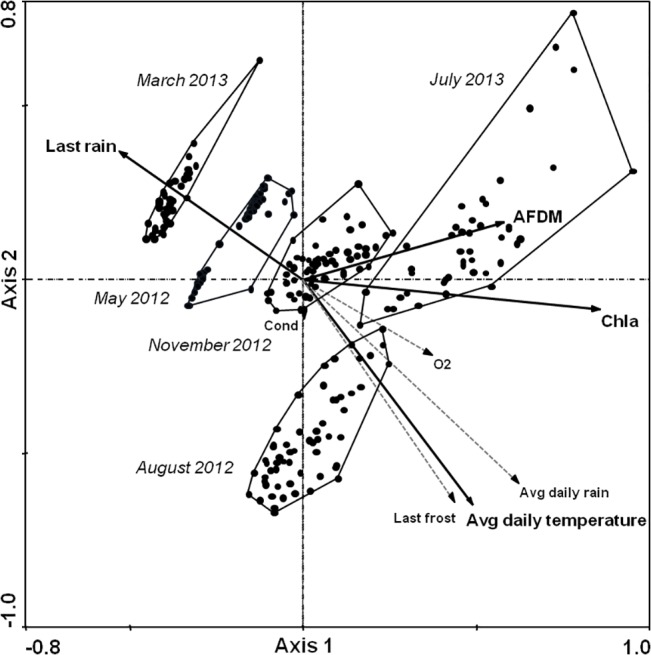
Redundancy analysis biplot of the 264 artificial tree hole communities and eight environmental factors.Significant predictors of the organismal density distribution are shown in bold. Samplings made on the same date are framed. For an explanation of the environmental factor abbreviations, see Fig 2. Sum of all canonical eigenvalues: 0.237 (axis 1: 0.208; axis 2: 0.021).